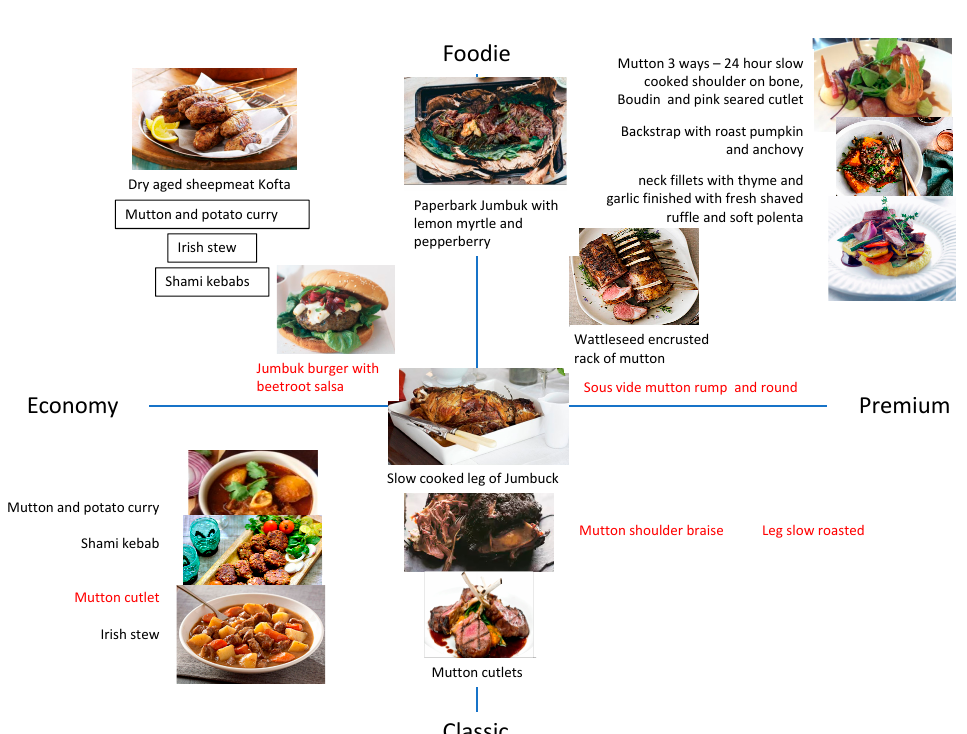
Figure A1. Melbourne perceptual mapping results; red font denotes tasted dishes, black font denotes image/concepts, and concepts that are enclosed in a black border were mapped more than once as the group could not reach consensus).